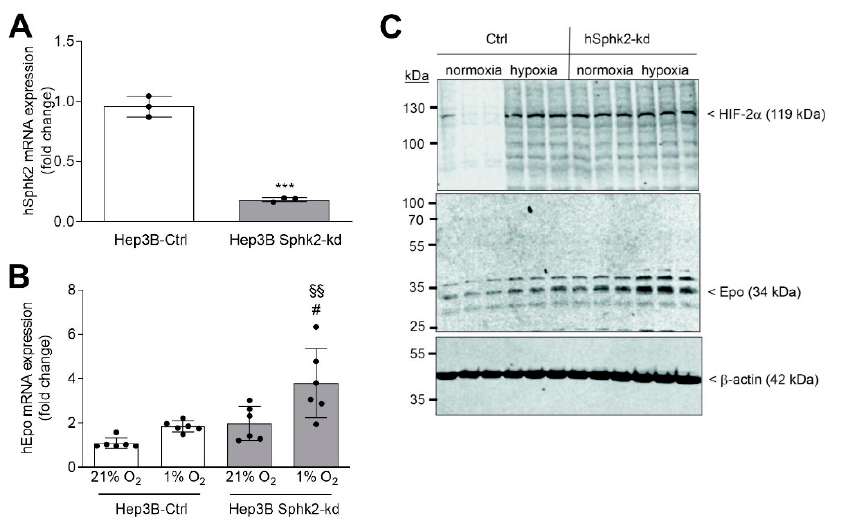
Figure 8. hSphk2 knockdown affects hypoxia-induced HIF-2 α and Epo protein expression in the human hepatoma cell line Hep3B. Hep3B cells were transduced with a control shRNA construct (Ctrl) or with a hSphk2 shRNA construct (hSphk2-kd), and stably selected cells were either exposed for 6 h to normoxia (21% oxygen) or hypoxia (1% oxygen). ( A , B ) mRNA was analyzed by qPCR using primers of hSphk2 ( A ) and hEpo ( B ), and 18S (for hSphk2) and hL28 (for Epo) mRNA for normalization. ∆∆ Ct values were calculated and normalized to 18S or L28, respectively. Results are expressed as fold change compared to normoxic control cells and are means +/ − S.D. ( n = 6), *** p < 0.001 was considered statistically significant when compared to the normoxic control; # p < 0.05 compared to the normoxic hSphk2-kd cells; §§ p < 0.01 compared to the hypoxic Ctrl cells. ( C ) Protein was analyzed by immunoblotting using antibodies against HIF-2 α ( C , top panel), Epo ( C , middle panel), or β -actin ( C , bottom panel). Corresponding bands were evaluated by using Image Studio